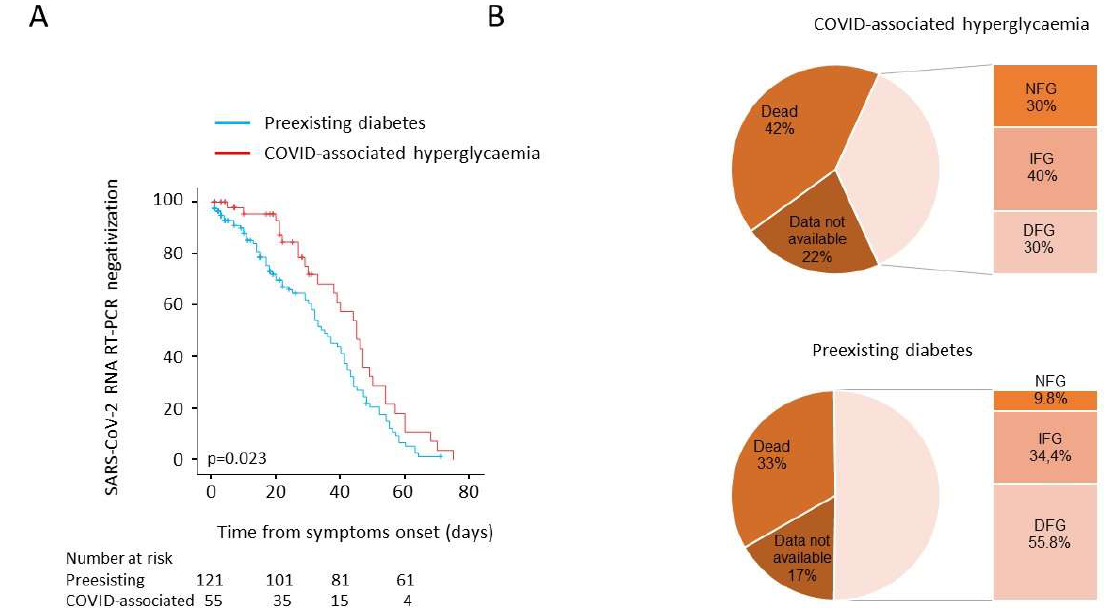
Figure 3. ( A , B ) Post discharge follow-up: time to NT swab negativization and persistence of hyperglycaemia. Kaplan–Meier estimates of the time to NT swab negativization for 176 patients with COVID-19 pneumonia ( A ). NT swab negativization was estimated in patients with COVID-associated hyperglycaemia ( n = 55) or pre-existing diabetes ( n = 121). The log-rank test was used to test differences between groups. Crosses indicate censored patients (censoring for death or end of follow-up). Fasting blood glucose during the post discharge follow-up ( B ). Valid glucose measurements during follow up (median 6 month) was available for 61 out of 121 and 20 out of 55 patients with pre-existing diabetes or COVID-associated hyperglycaemia, respectively. NFG: normal fasting glucose, <5.6 mmol/L; IFG: impaired fasting glucose 5.6-6.9 mmol/L; DFG: diabetes fasting glucose ≥ 7